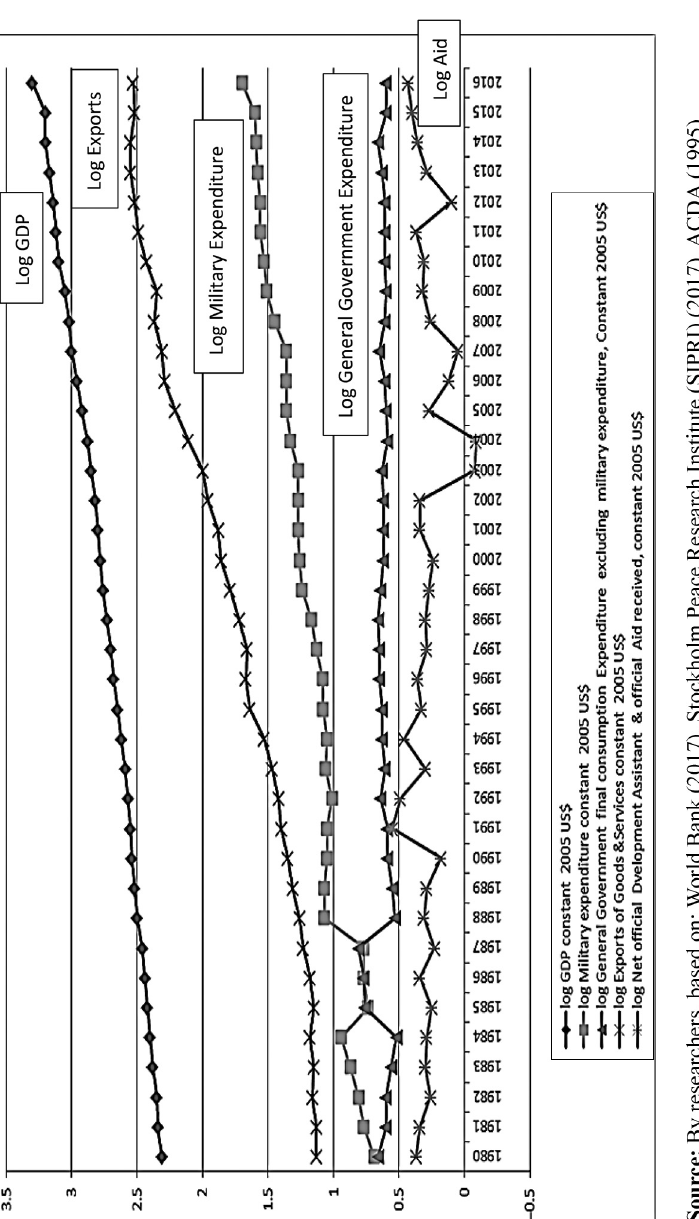
Figure 1. GDP, military spending, government spending and aid at constant prices during the period